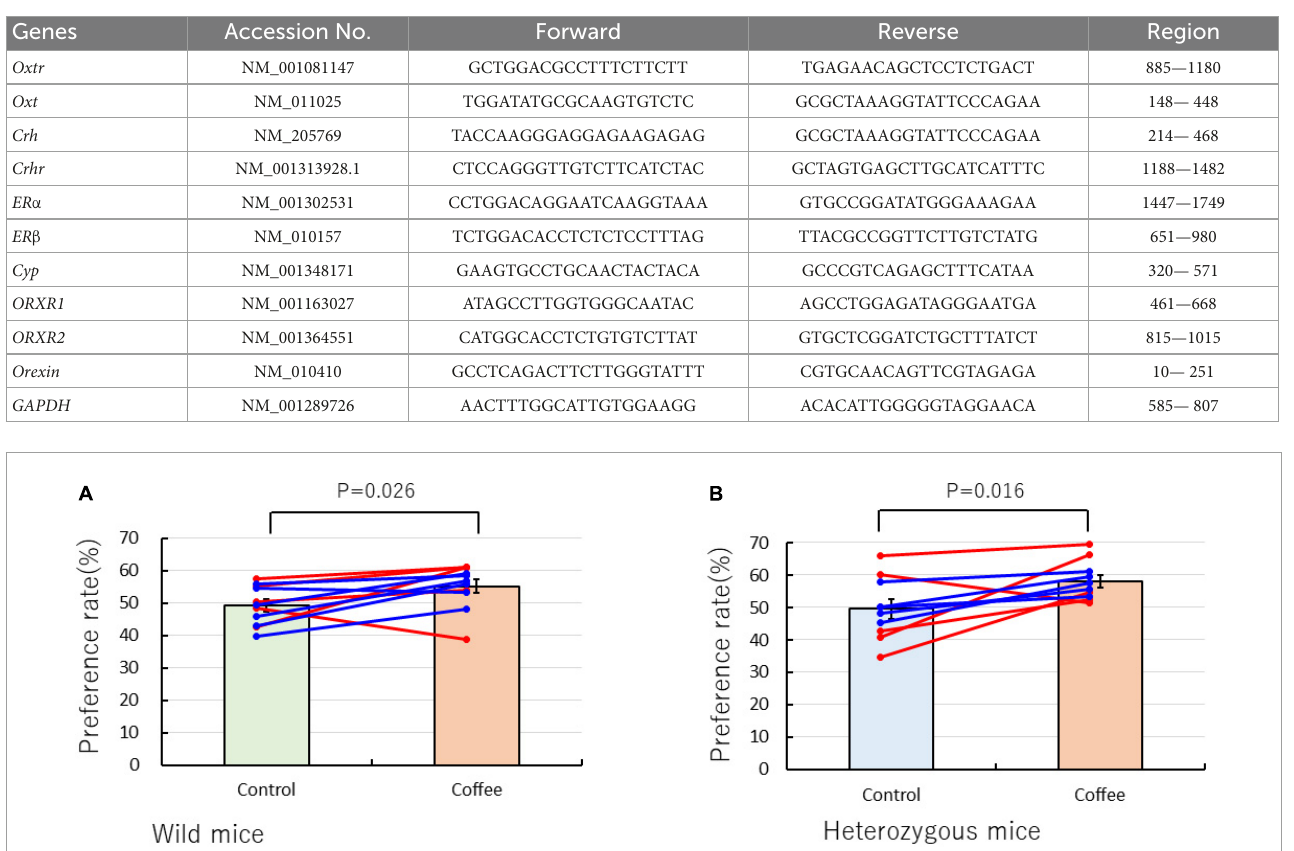
FIGURE2 Y-maze preference test of wild-type oxytocin receptor (OXTR) (+/+) mice and heterozygous OXTR ( ± ) mice to the coffee odor. The mean ± standard error preference rate (%) of the control (water vs. water) and coffee odor tests (water vs. grained coffee beans) were compared. (A) Wild-type mice (male = 6, female = 5) and (B) heterozygous mice (male = 5, female = 5) were used. The male and female data are described, respectively, in blue and red symbols and lines. The statistical significance of the differences between each of the samples was assessed by the Wilcoxon signed-rank test. An a-value of P < 0.05 was considered statistically